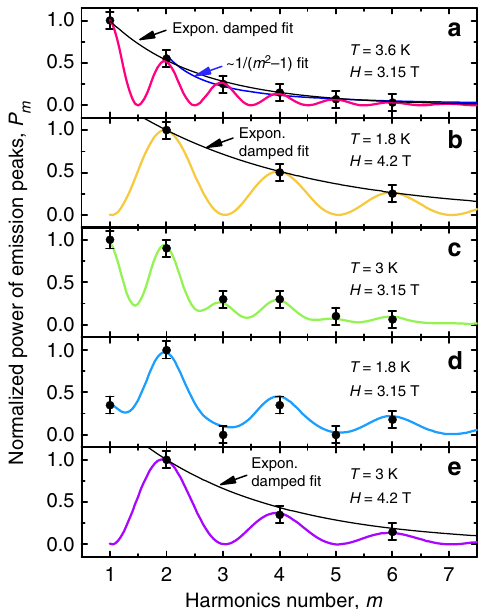
Fig. 6 Intensity of higher harmonics in the microwave radiation. Normalized emission power P m as a function of the harmonics number m for a vortex velocity of v = 75 m s − 1 . The assumed superposition of the em wave emission associated with the 100 Å spacing between the vortex rows ( a ) and the 50 Å-periodic layered structure ( b ) is used to explain the spectrum modi fi cation in c , d . The spectrum at 3 K ( e ) exhibits a stronger damping of higher harmonics as compared to 1.8 K ( b ). Symbols are P m values deduced from the spectra in Fig. 2. Solid lines are fi ts as indicated. Error bars depict Fig. 5 Superconductivity dimensionality crossover in the Mo/Si the doubled standard deviation encompassing about 95% of the and out-of-plane H jj c upper critical fi elds superlattice. a The in-plane H jj b c2 c2 versus temperature. Solid lines are fi ts ∝ ( T c − T ) in the 3D regime and ∝ ( T − T ) 1/2 in the 2D regime. The 2D – 3D crossover temperature T * ffiffiffi p c 2 is indicated. b Temperature dependence corresponding to ξ c T (cid:5) ð Þ ¼ s = of the vortex core size ≃ 2 ξ c with the different regimes determined by the relation of ξ c and the multilayer period s . Large circles indicate the temperature at which the emission spectra in Fig. 2 have been acquired